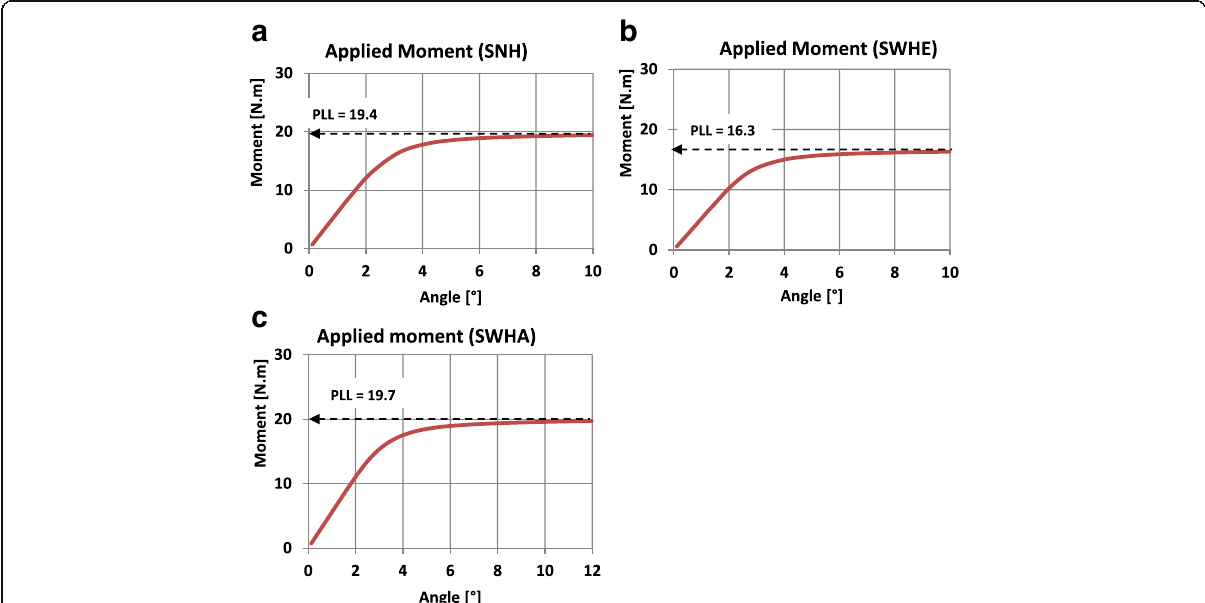
Fig. 13 Determination of PLL: Nonlinear load – displacement diagrams. Only the curves from the 3D FEA (case study H) are shown here. a Specimen SNH, b Specimen SWHE, c Specimen SWHA